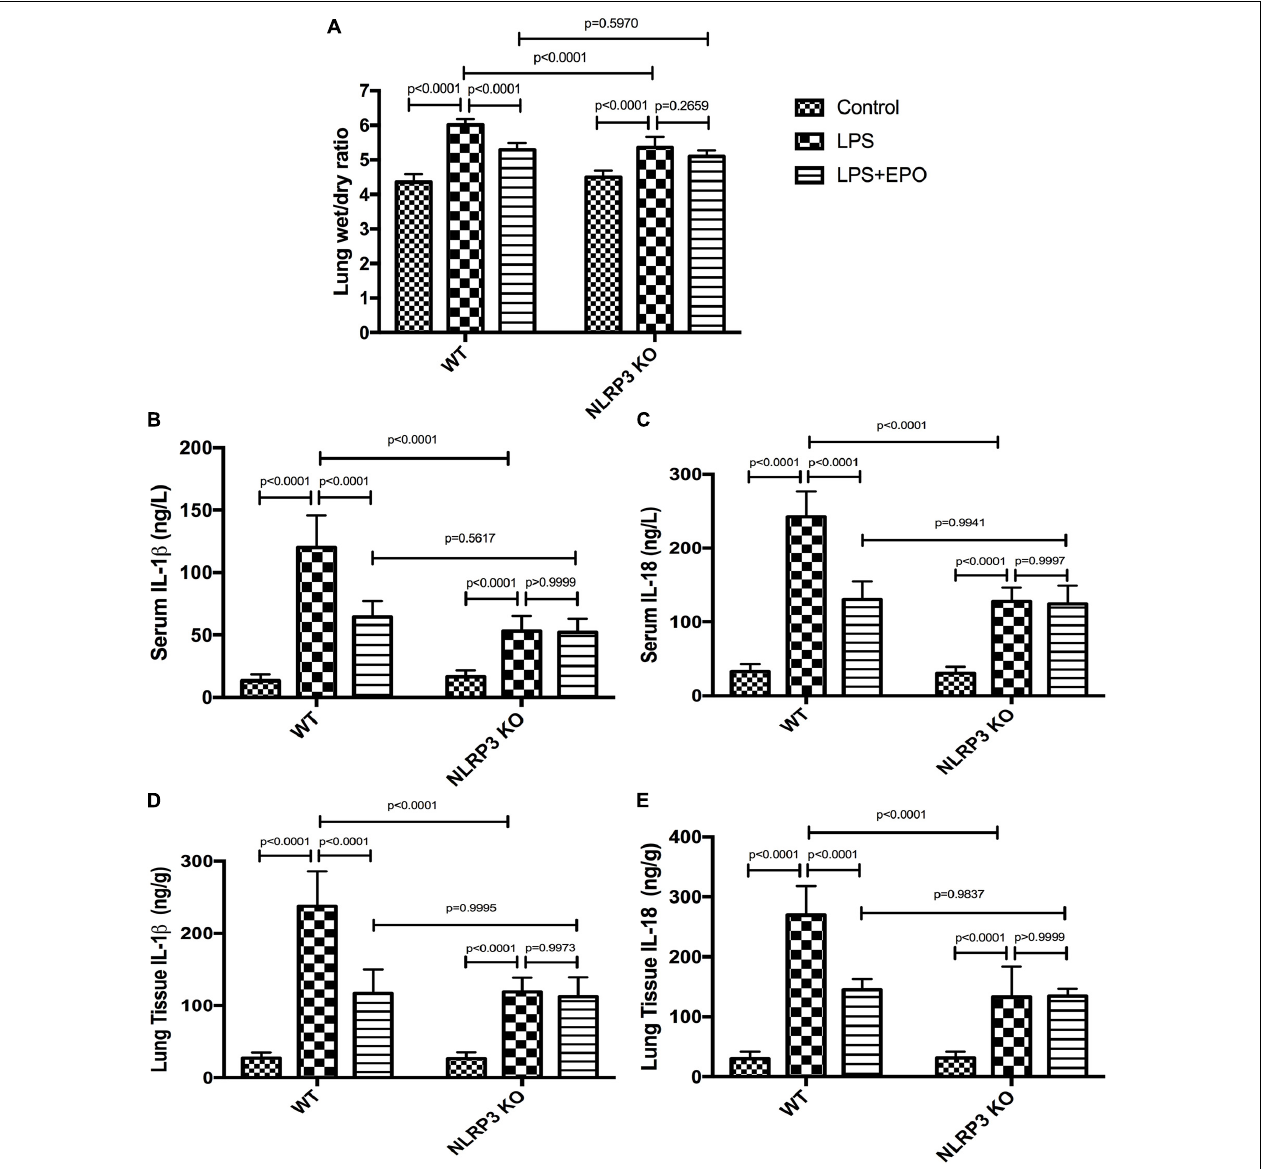
FIGURE 9 | EPO attenuated lung injury and inhibited IL-1 β and IL-18 secretion, which was dependent on NLRP3 in LPS-induced ALI. EPO (5 U/g) was injected into the peritoneal cavity of mice after LPS (15 mg/kg) stimulation in NLRP3 knockout (KO) mice and wild-type (WT) mice, and the mice were sacrificed 8 h later. The lung tissues were harvested to measure the lung wet/dry ratio (A) and the concentrations of IL-1 β and IL-18 (D,E) by ELISA. The sera were obtained to measure the concentrations of IL-1 β and IL-18 (B,C) by ELISA. The data are presented as the mean ± SD. The differences among groups were assessed by two-way ANOVA and the post hoc test (Turkey method) was applied to investigate the differences one by one. n = 7 per